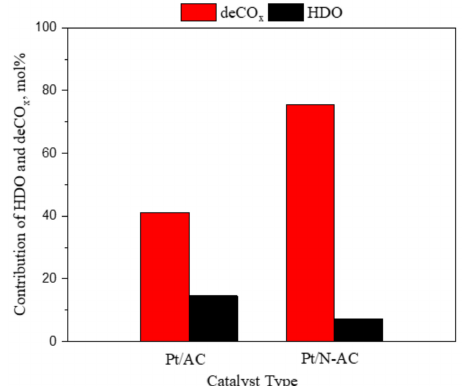
Figure 9. Contribution of HDO and DeCO x over Pt / AC and Pt / N-AC catalysts.